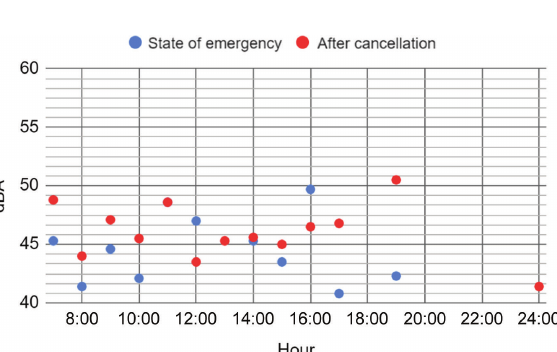
Comparison of the day history of the , T = 30 s) of Sunday noise levels (L Aeq during the state of emergency (17 May 2020) (blue) and after its cancellation (24 May 2020)